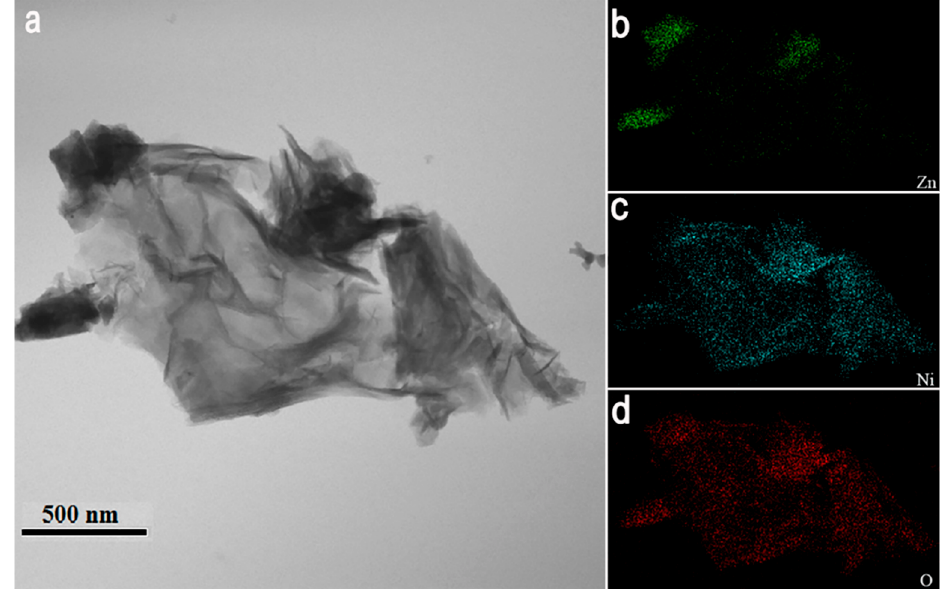
Figure 3. ( a ) TEM bright-field image of NiO/ZnO heterostructures and ( b – d ) elemental mapping of NiO/ZnO heterostructures.